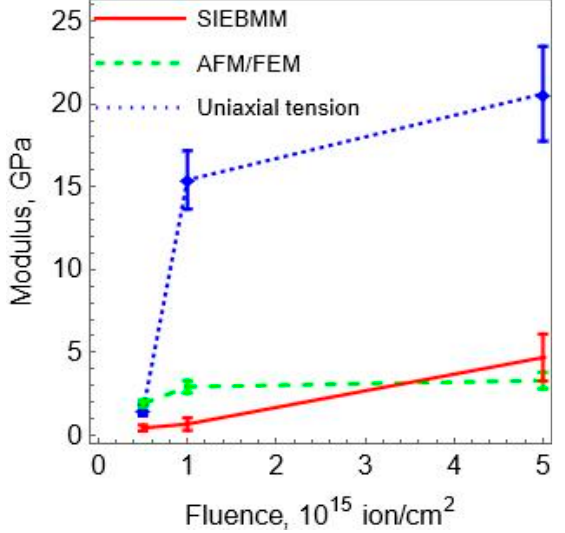
Figure 10. Mean values and RMS deviation of the elastic modulus of the carbonized layer formed at different fluences of ion treatment. The values of the modulus were determined using different techniques: SIEBMM (red), numerical experiment using AFM data (green), uniaxial stretching of the composite beam (blue).